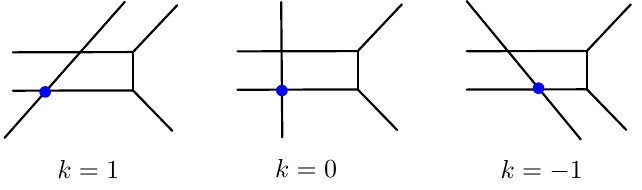
Figure 4 . Note that the SL(2 , Z ) symmetry in type IIB string theory preserves in 3d brane webs. This symmetry only changes slopes of 5-branes but does not change the relative angle and the effective CS